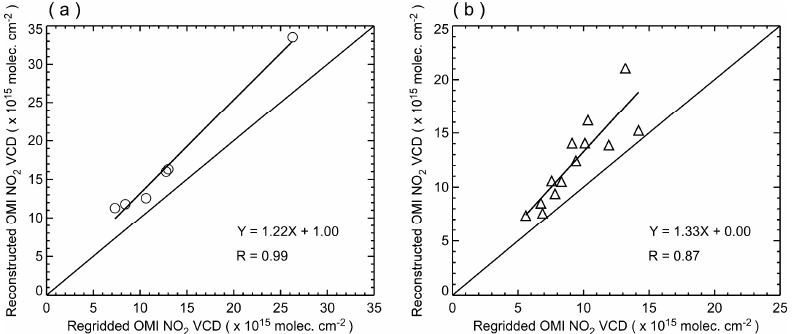
Figure 11. A comparison of re-gridded and reconstructed OMI NO 2 VCD on an effective spatial resolution for (a) 6 urbanized area sources and (b) 13 isolated point sources in South Korea.